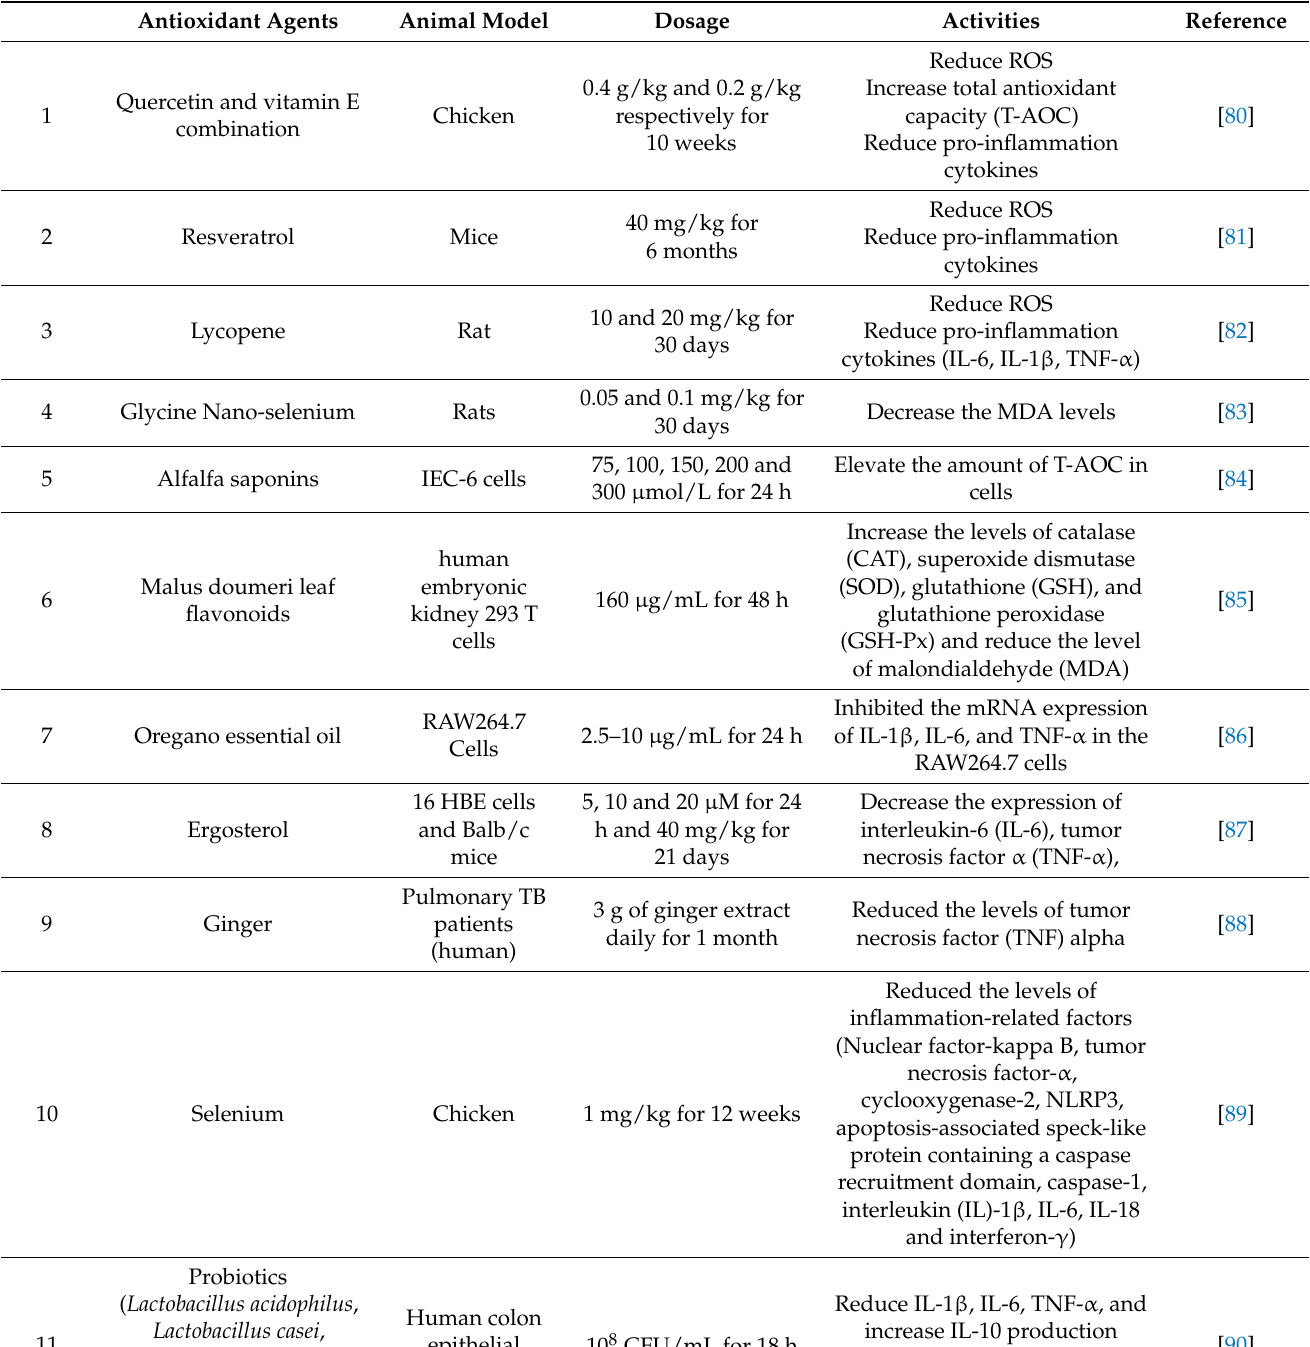
Table 1. Potential antioxidant and anti-inflammatory agents for treatment of A. adenophora –induced toxicity. Antioxidant Agents Animal Model Dosage Activities